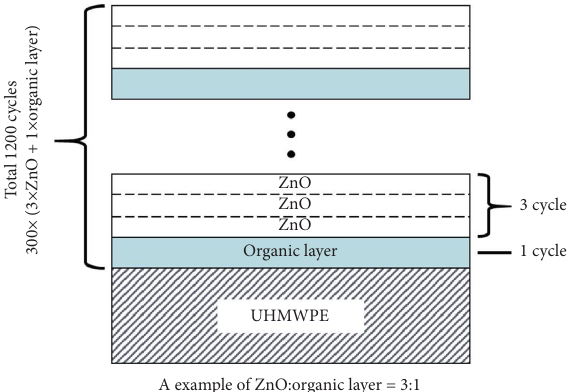
Figure 2: Ratios of the ZnO and organic layers were controlled by changing the number of cycles in each layer. An example of ZnO: organic layer � 3:1 is